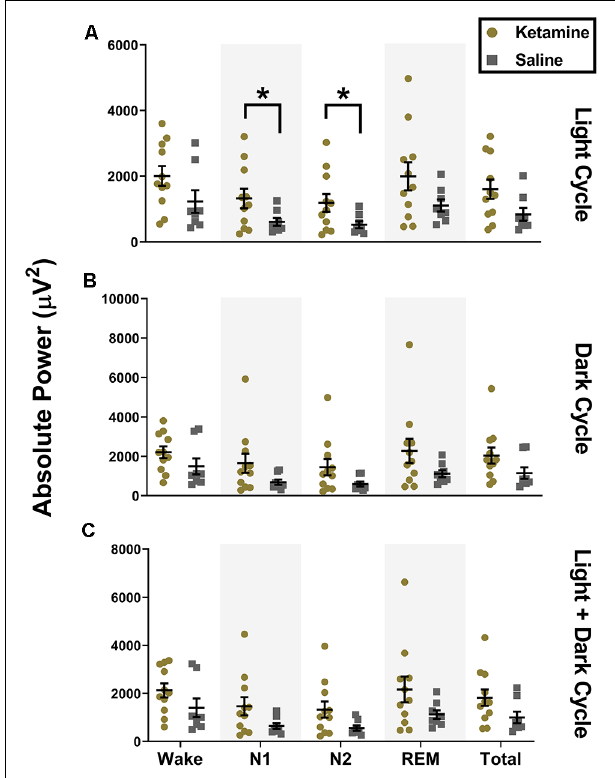
FIGURE 3 | Neonatal ketamine exposure increases subicular low gamma power during N1 and N2. (A) Neonatal ketamine exposure resulted in a significant increase in power spectra in the low gamma frequency ranges during N1 and N2 of the light cycle ( P = 0.049 and P = 0.033 for N1 and N2, respectively). However, also during the light cycle, there were no changes in low gamma oscillations during Wake ( P = 0.078), REM ( P = 0.065), or across total recording period ( P = 0.052). (B) During the dark cycle, there was an increase in low gamma power during N2 ( P = 0.040), but not during N1 ( P = 0.053), Wake ( P = 0.096), REM ( P = 0.083), or across total recording period ( P = 0.057). (C) When both cycles were combined, we saw an increase in low gamma during N1 ( P = 0.049) and N2 ( P = 0.033). Consistent with results in the light and dark cycle separately, we did not note any changes in low gamma oscillations during Wake ( P = 0.083), REM ( P = 0.075), and across the total recording period when both cycles were combined ( P = 0.052; * P < 0.05).